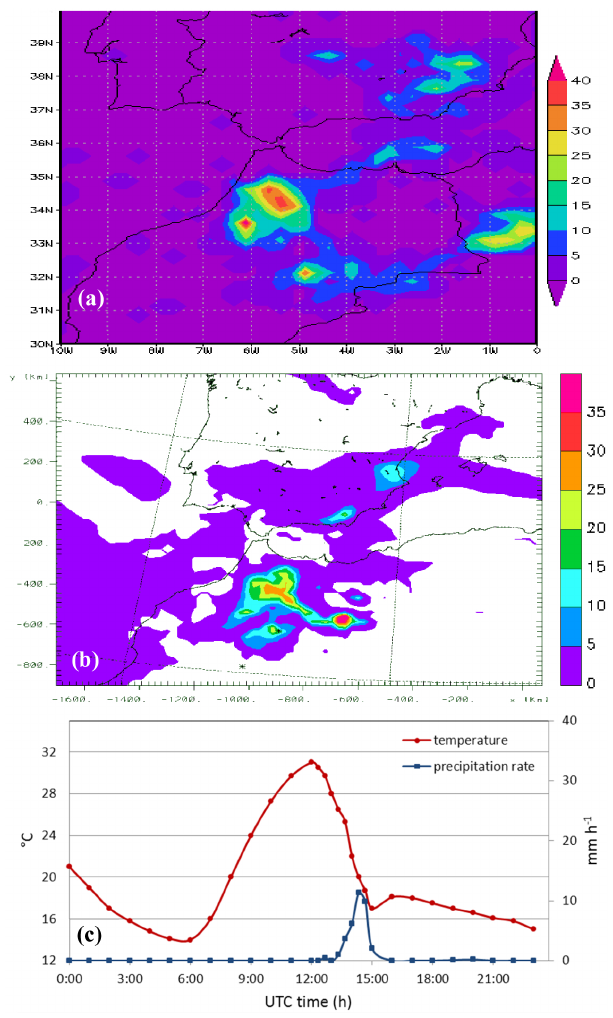
Fig. 2. (a) Satellite retrieval of 24h accumulated precipitation (mm) from the Tropical Rainfall Measuring Mission (TRMM – http:// trmm-fc.gsfc.nasa.gov/trmm gv). (b) Model output of 24h accumu- lated precipitation (mm). (c) Modeled precipitation rate (mmh − 1 ) and temperature ( ◦ C) at the station of Errachidia on 31 May 2006. The drop in temperature between 12:00–15:00UTC indicates the formation of a cool pool due to the evaporation of rain